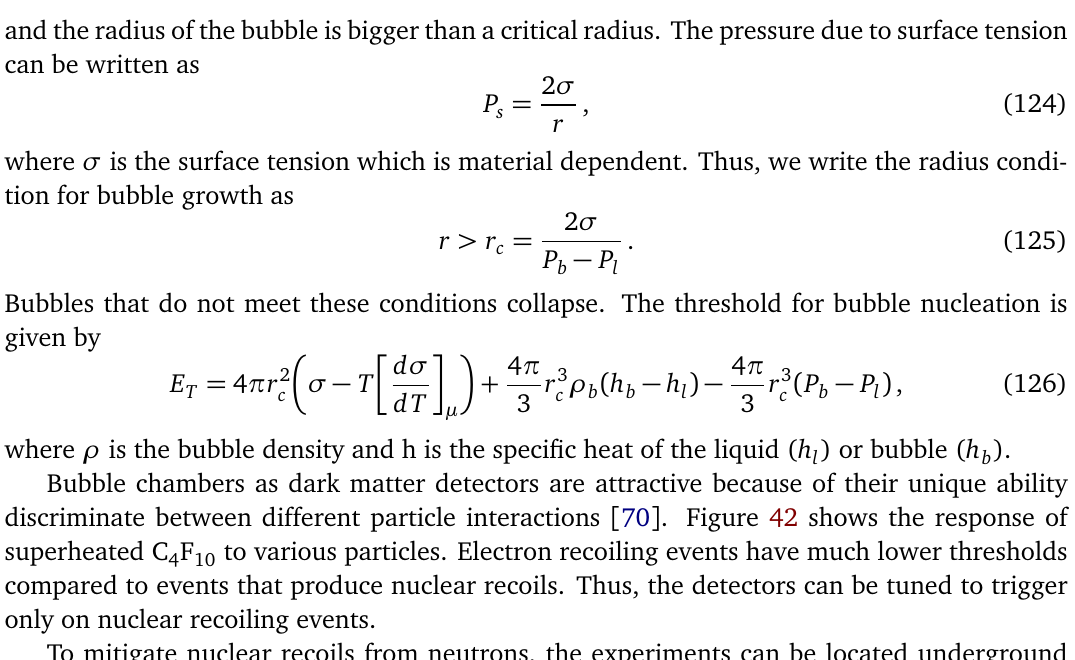
Figure 42: Detector response to different particles in superheated C to right: 1.75 MeV γ -rays and minimum ionizing particles (dot-dashed); model of 50 GeV / c 2 WIMP (red); polyenergetic neutrons from an AcBe source (dotted); α particles at the Bragg peak from 241 Am decays (open triangles); and 210 Pb recoil nuclei from 226 Ra spikes(dots) Taken from [ 70 ]